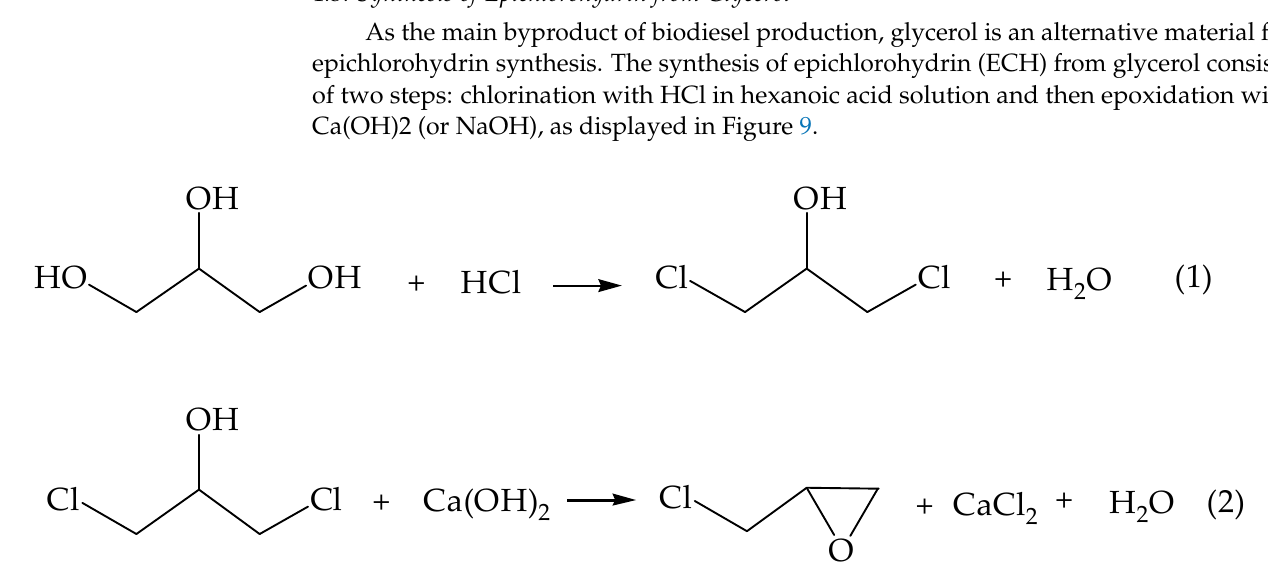
Figure 9. Reaction mechanism of epichlorohydrin synthesis from glycerol.